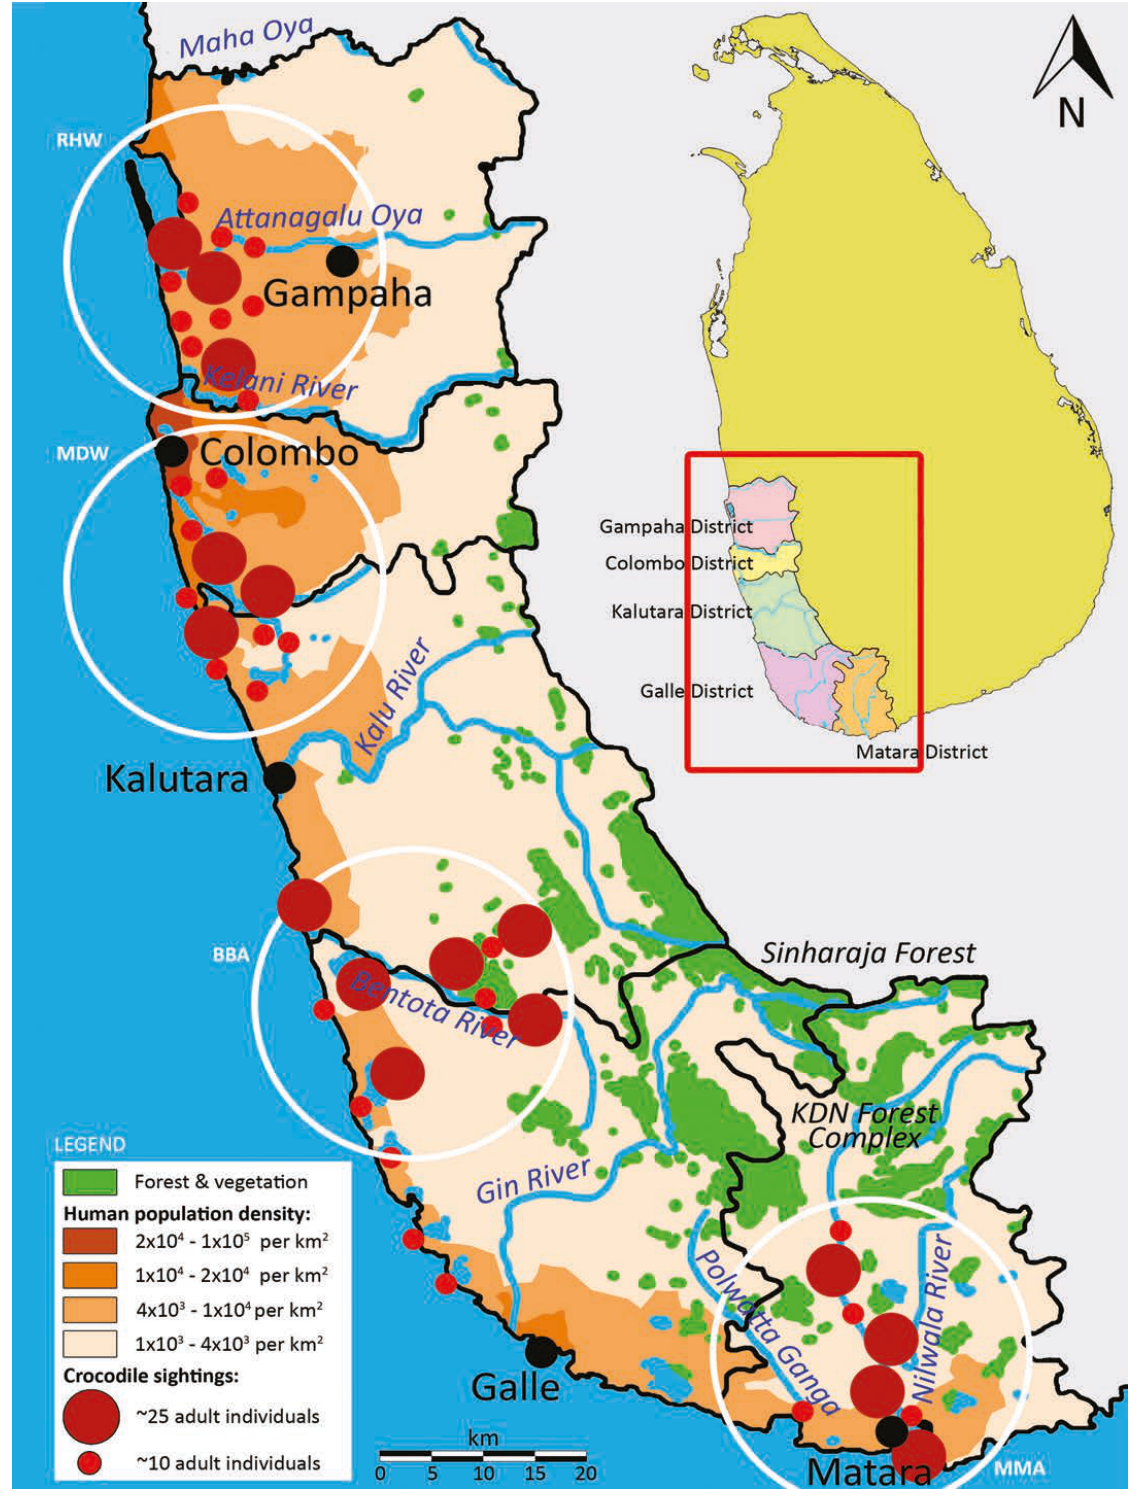
Image 1. Study area showing the habitat and human population density